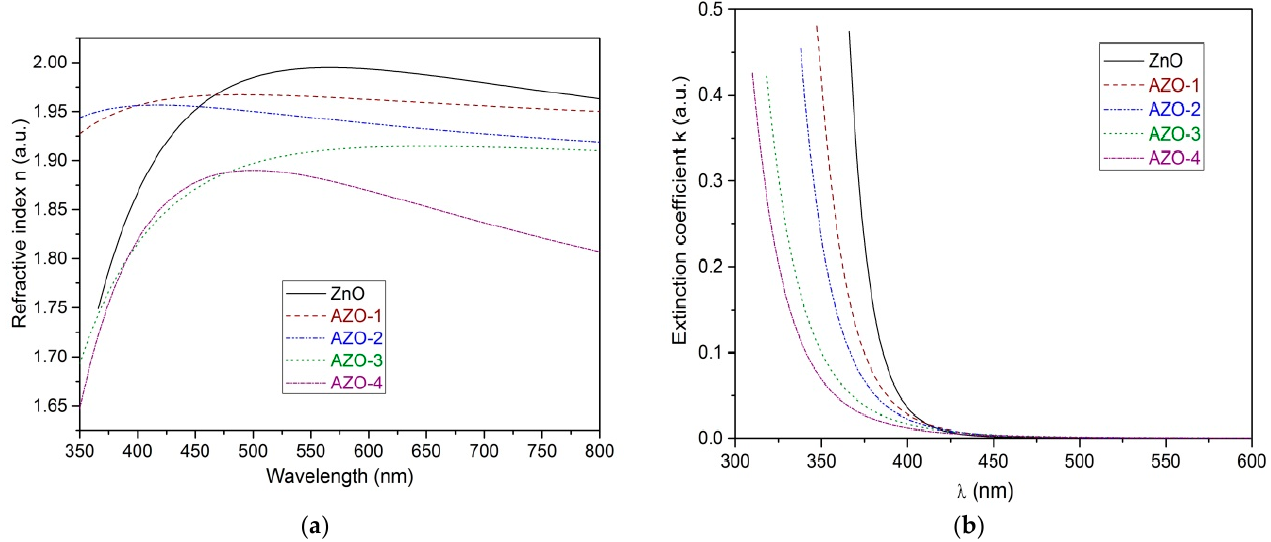
Figure 10. The spectral dependences of: ( a ) the refractive index n and ( b ) the extinction coefficient k , obtained by the use of the Cauchy model.